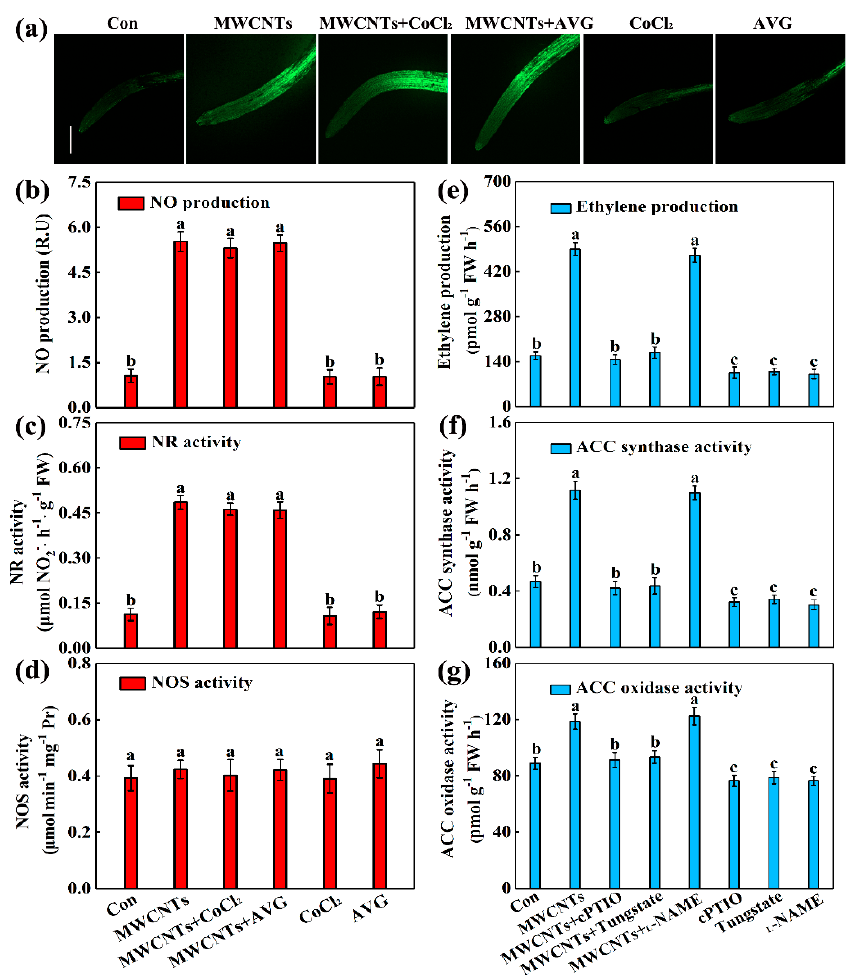
Figure 4. Cross-talk between NO and ethylene. Two-day-old rapeseed seedlings were treated